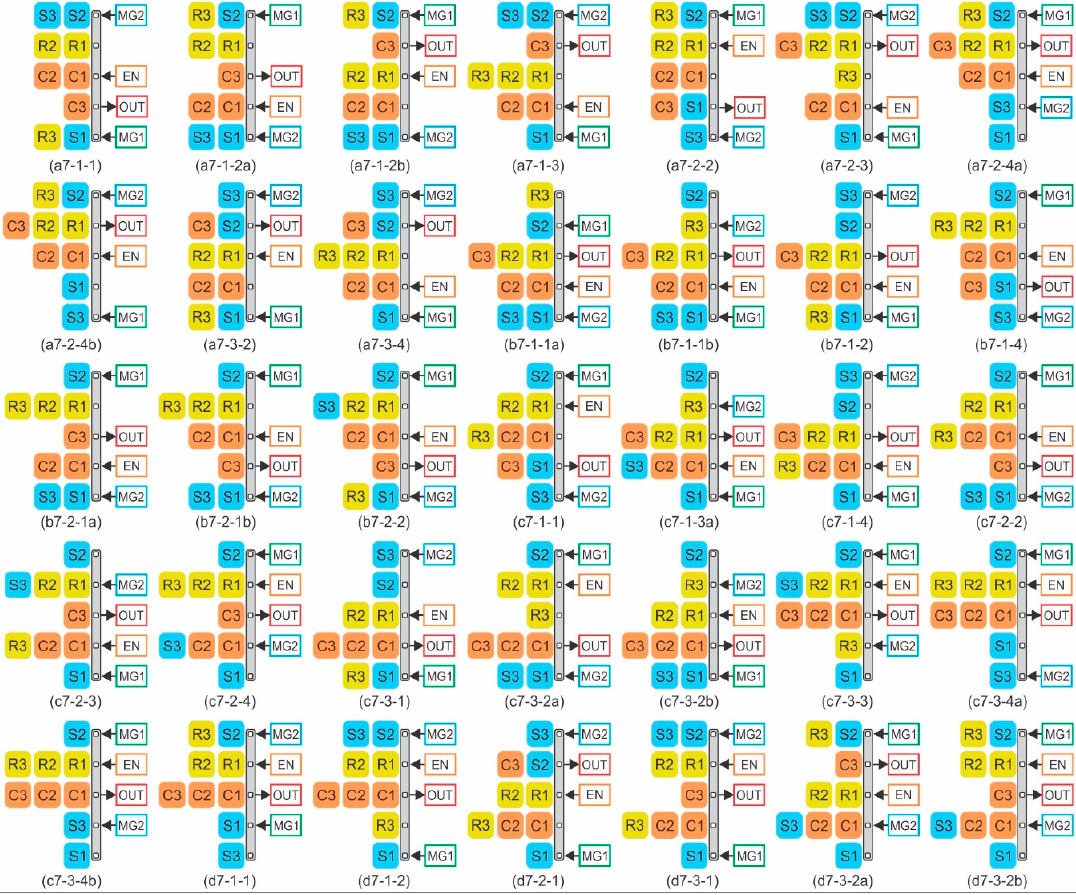
Figure 13. Atlas of feasible levers.